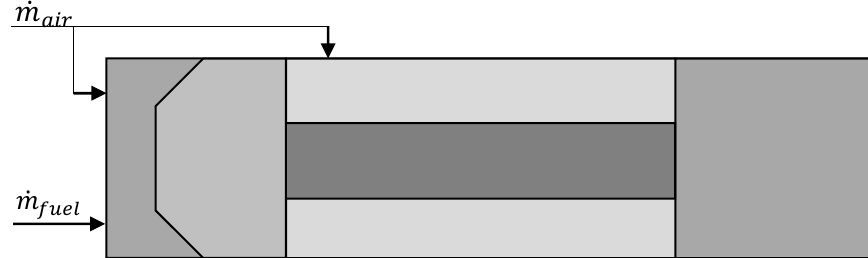
Figure 5. Schematic of the CRN employed to estimate the composition of the gases leaving the lean-premixed combustor. Each region represents a PSR.